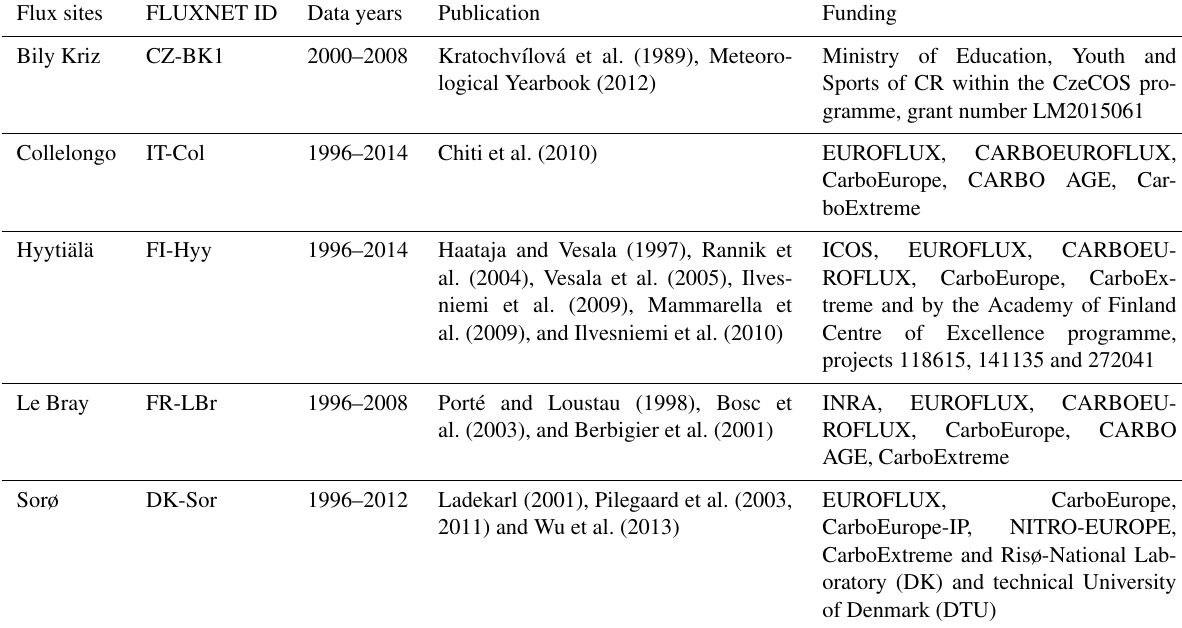
Table A1. List of FLUXNET sites used in PROFOUND